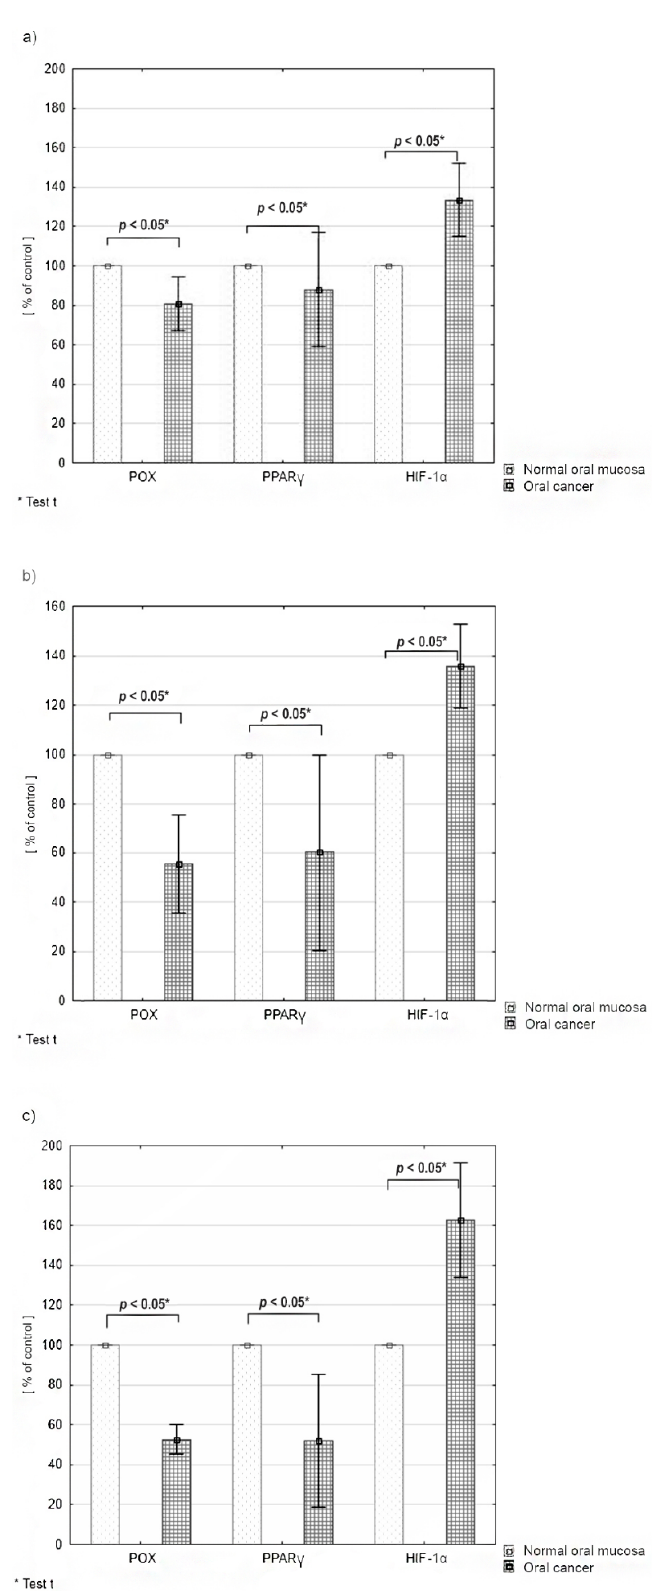
Figure 3. Differences in the expression of PRODH/POX, PPARγ and HIF-1α in tissue material grouped accordingly to the histological grade (G) and clinical malignancy of tumour: ( a ) G1, ( b ) G2, ( c ) G3.